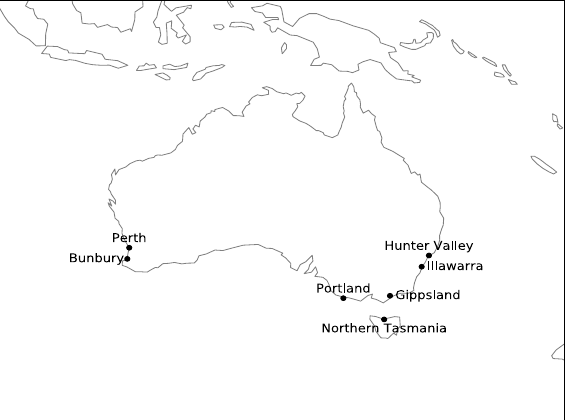
Figure 1. Locations identified as having potential for offshore wind energy generation [5]. Figure 1: Plot of locations identified as having potential for offshore wind energy generation (Bowen, 2022) Many factors must be taken into account when selecting these potential